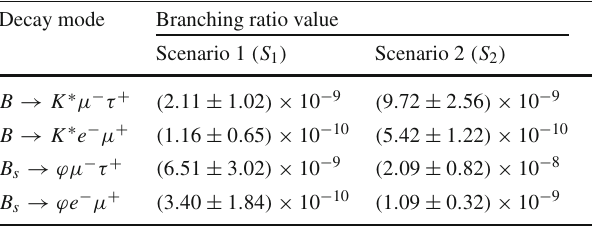
Table 3 Predicted values of branching ratios for LFV B → K ∗ and B s → ϕ decays in 1 st and 2 nd scenarios